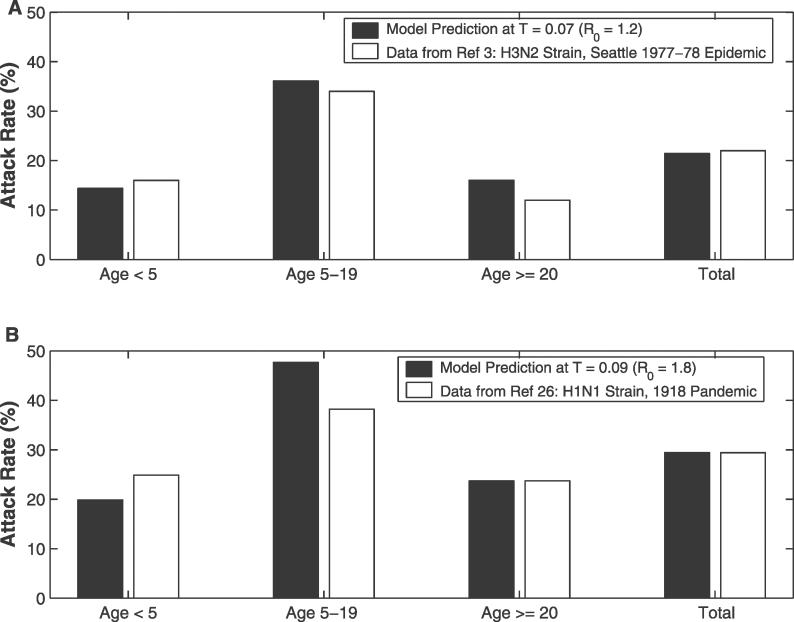
Model ValidationComparison of predicted to observed age-specific attack rates for (A) the 1977–1978 influenza season and (B) the 1918 influenza pandemic.